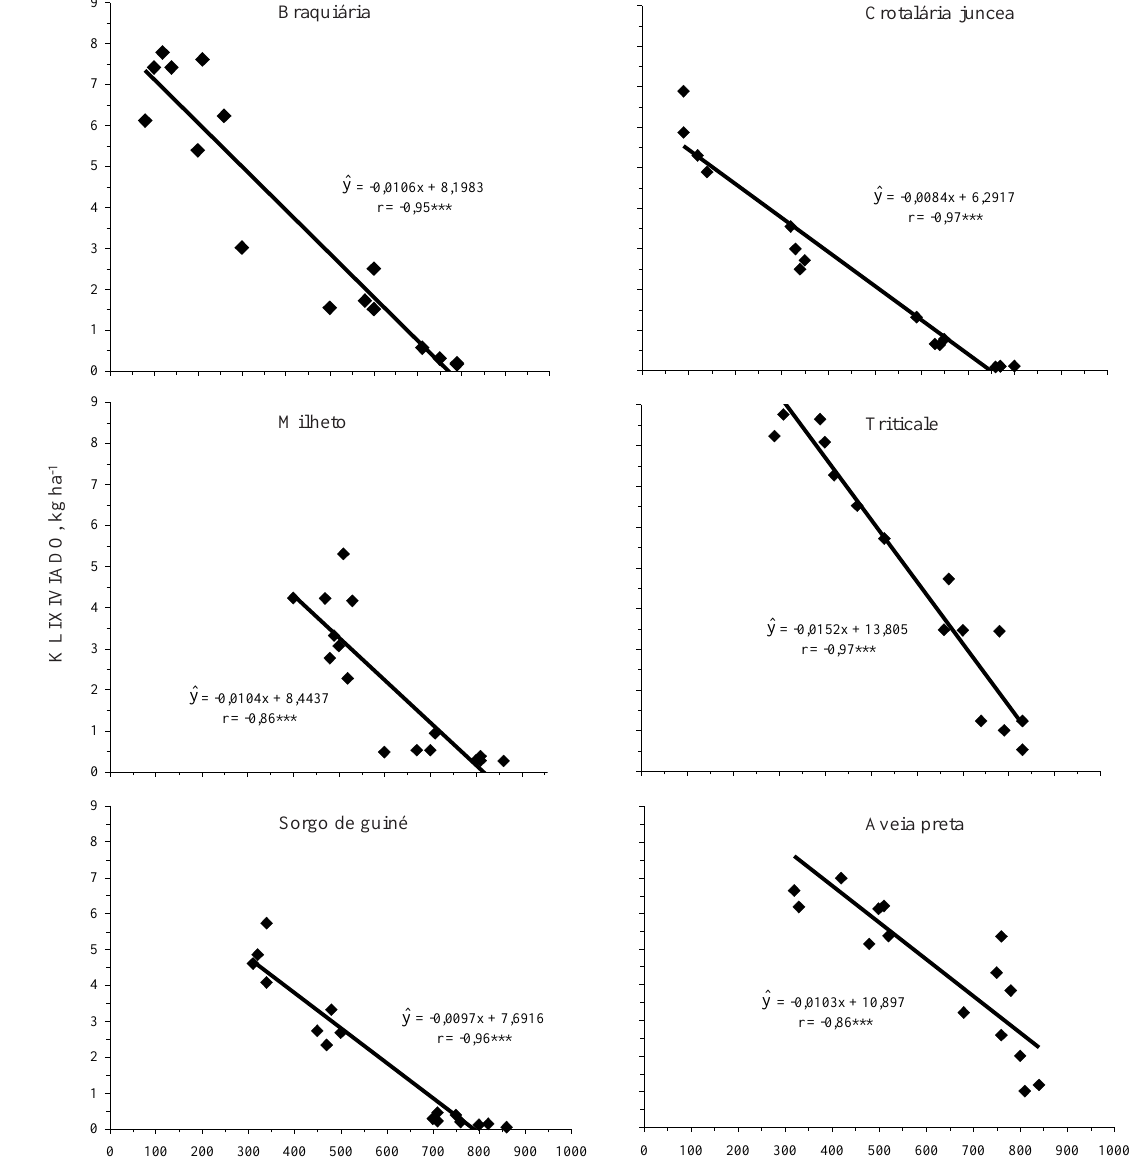
Figura 4. Correlações lineares entre as variáveis teor de água e quantidade de K lixiviada das palhas de plantas de cobertura, conforme a simulação de chuva em diferentes épocas após a dessecação química.*** significativo a 0,1% pelo teste